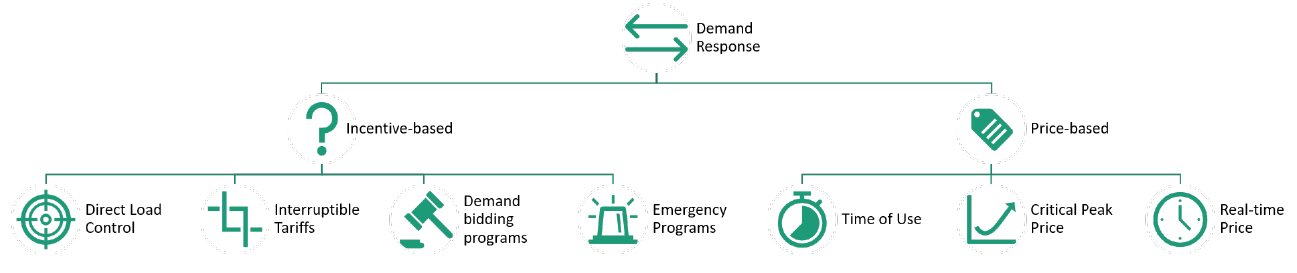
Figure 1. Classification of DR